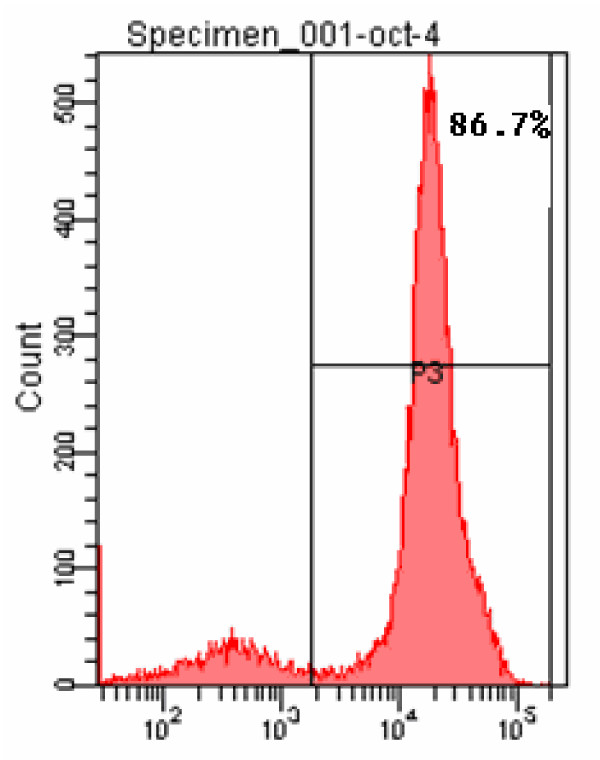
Oct-4 positive cells detected using flow cytometry. Two clusters of cells were segregated, of which the positive cells accounted for 86.7%.